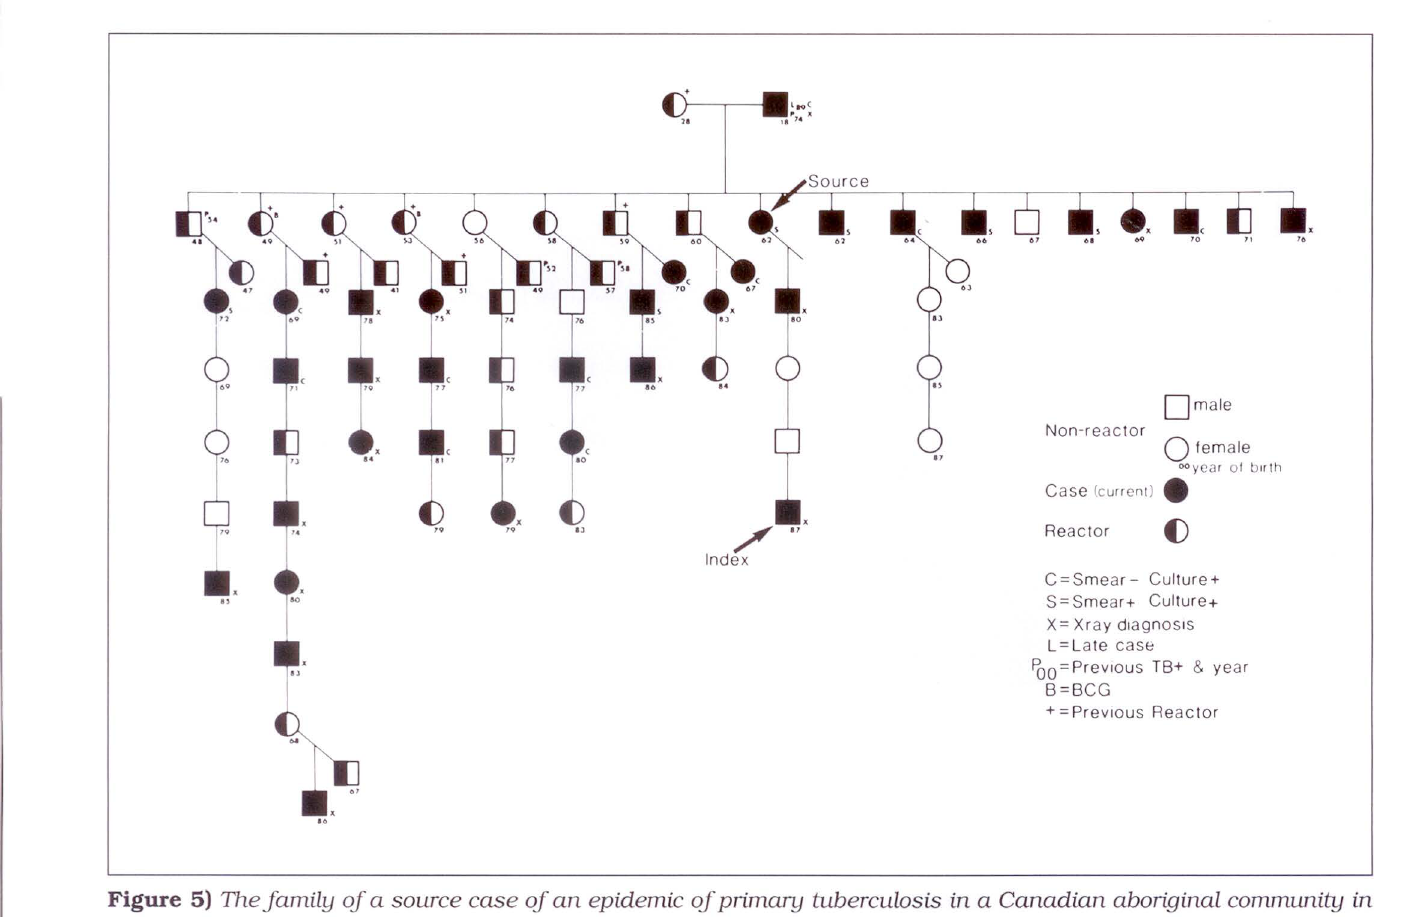
Figure 5) The family of a source case of an epidemic of primary tuberculosis in a Canadian aboriginal community